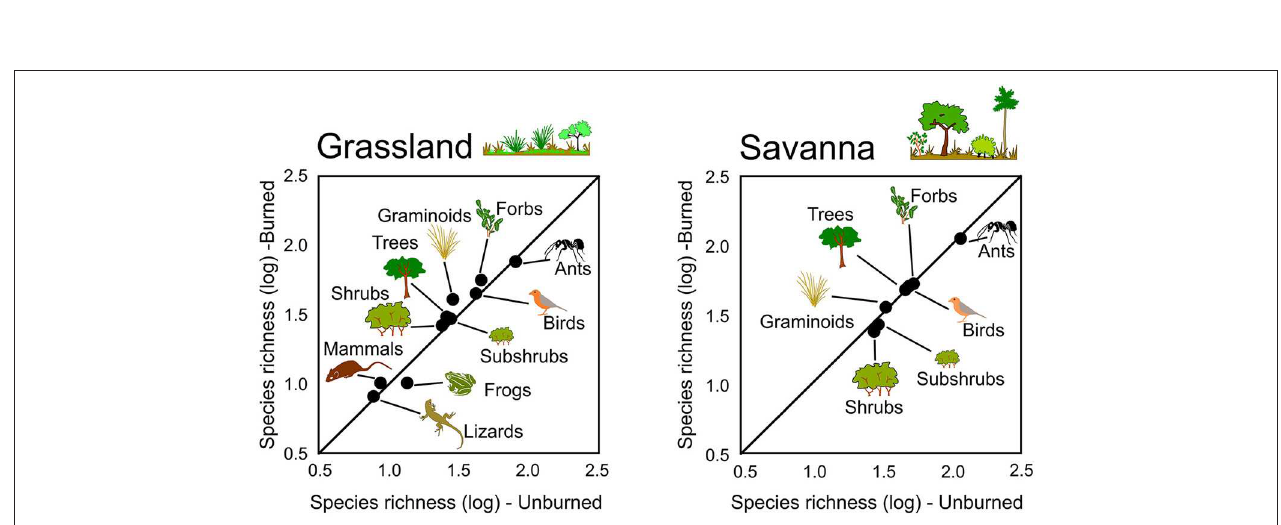
FIGURE 3 | Species richness (log 10 -transformed data) of different plant and animal groups in unburned and burned areas for grassland and savanna vegetation types. The line represents the 1:1 equivalence line, at Santa Bárbara Ecological Station, state of São Paulo, Brazil.